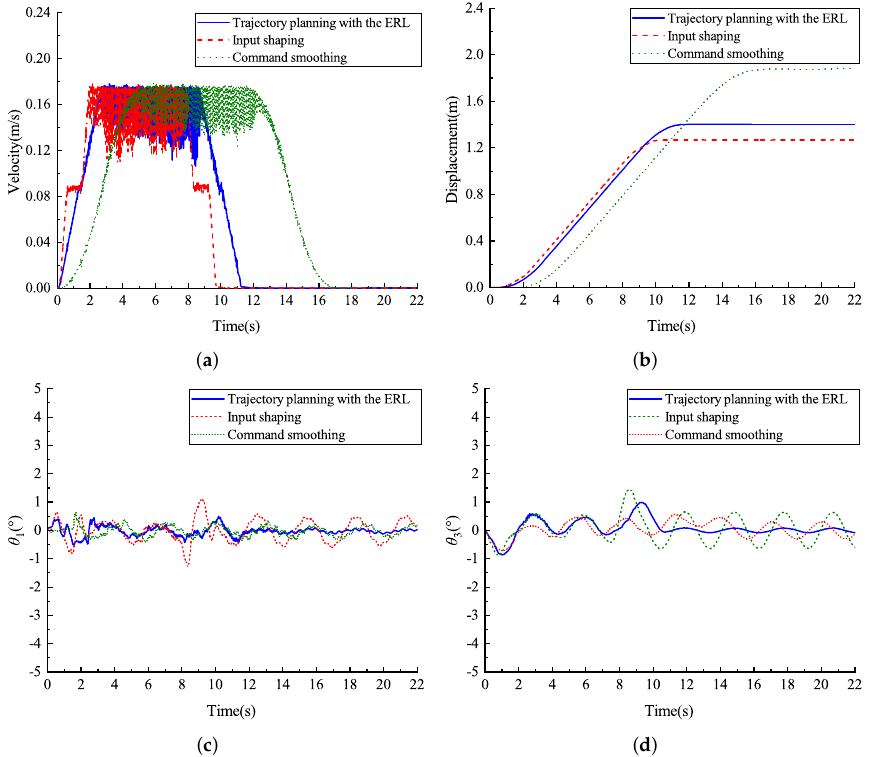
Figure 7. Comparative experimental results of the trajectory planning with the ERL, input shaping, and command smoothing. ( a ) velocity trajectories, ( b ) translational displacement, ( c ) oscillation responses of the hook, ( d ) oscillation responses of the DMP. Table 4. Comparative experimental